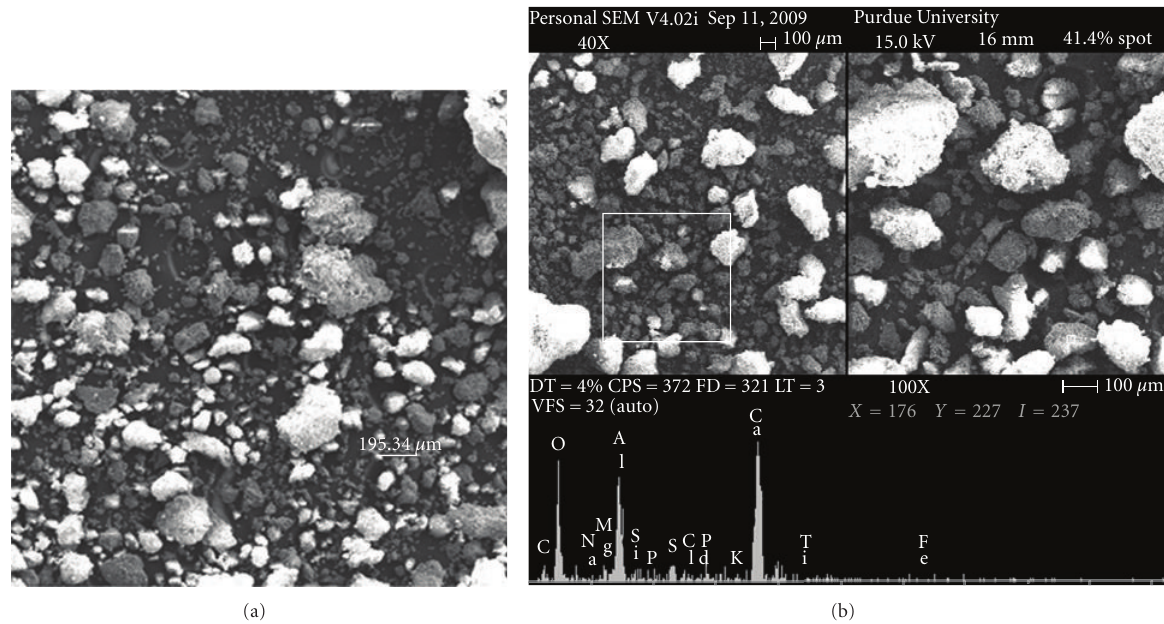
Figure 10: SEM micrographs of EAF(L) slag. (a) sand- and silt-size particle shapes (magnification = 50X) and (b) particles with their ele- mental analysis.